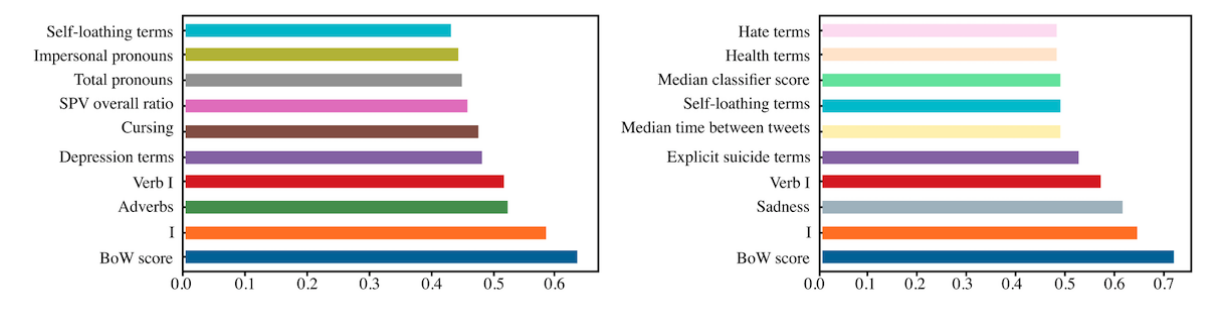
Figure 1. Features more correlated with the class to predict for both tasks: Suicidal ideation risk vs Focused control (left), and Suicidal ideation risk vs Generic control (right).